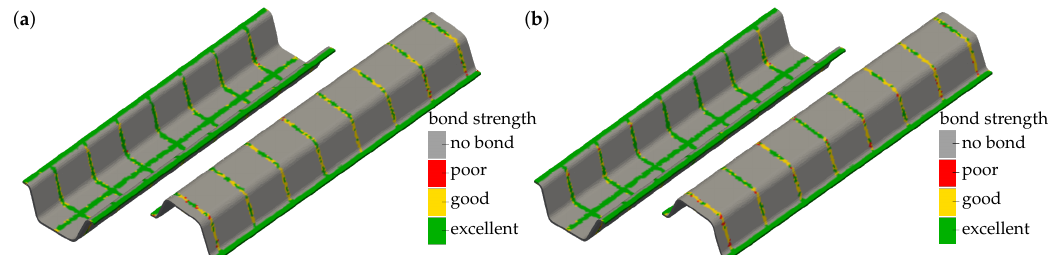
Figure 14. Quality measurement for sample 52. ( a ) Numerical result of full-scale simulation; ( b ) predicted result by Random